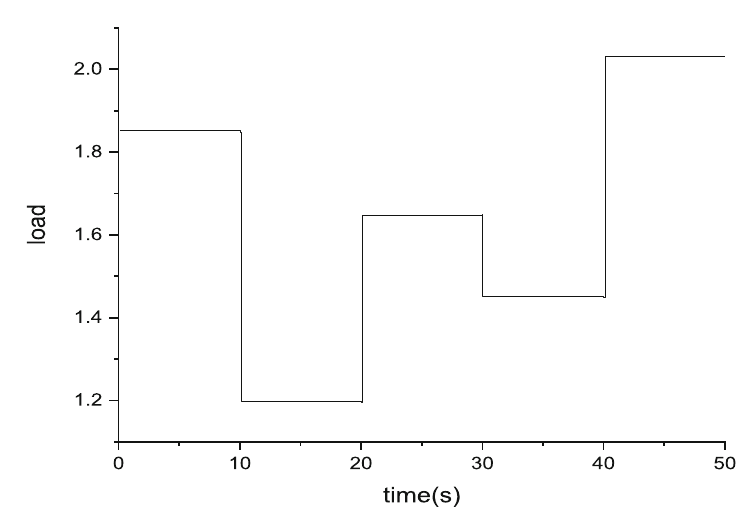
Fig. 6 Variable step load disturbance